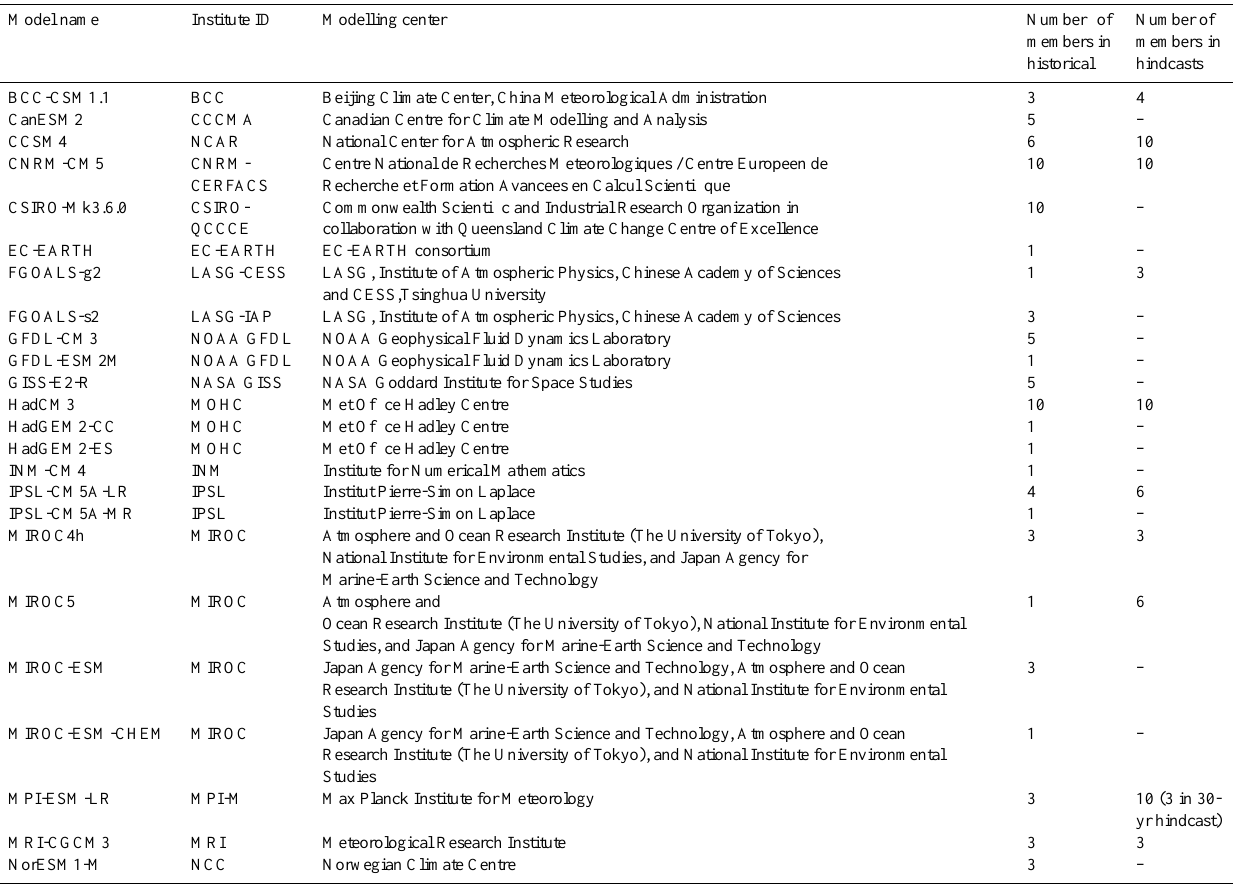
Table 1. Model name, Institute and number of members in models historical and hindcast